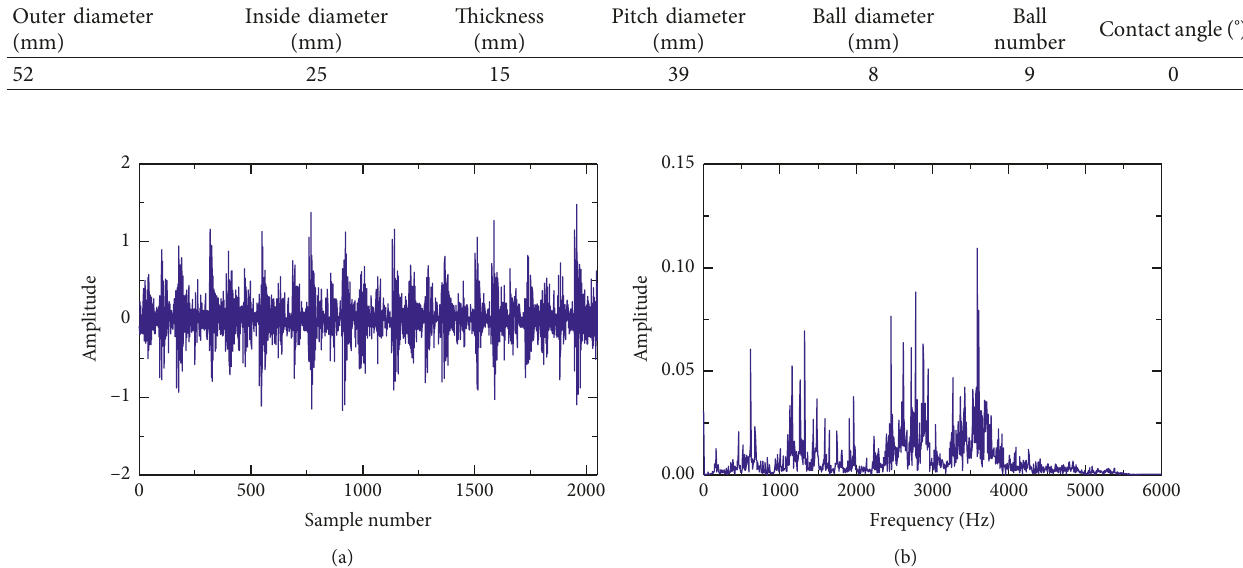
Figure 12: Waveform and amplitude spectrum of the inner race defect signal: (a) time-domain waveform; (b) amplitude spectrum.